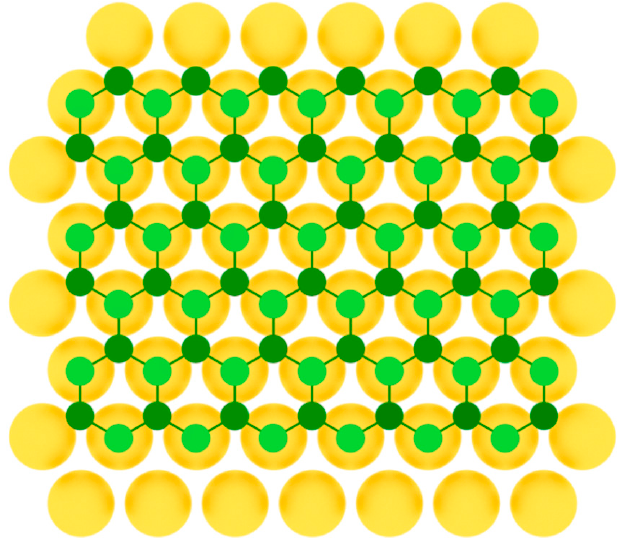
Figure 7. Model of buckled silicene layer on a metal substrate (two colors are used for silicon atoms at different height positions).